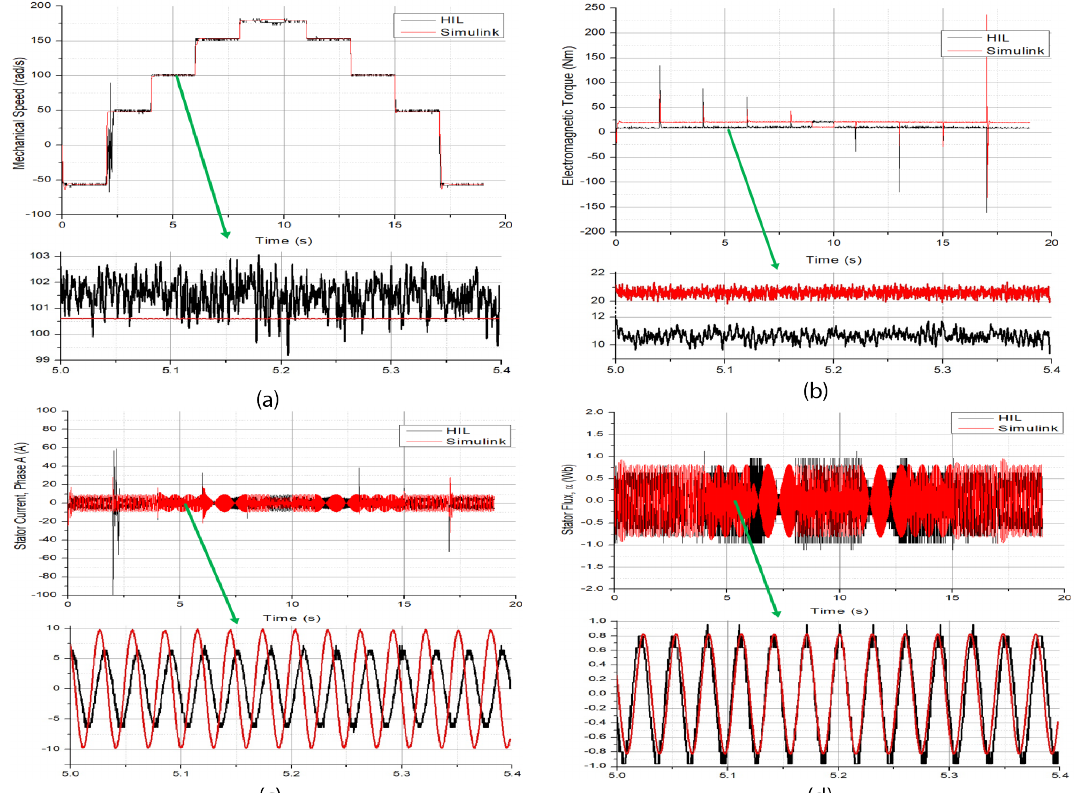
Figure 8. Numerical and practical results of the IFOC variable speed controller: ( a ) speed; ( b ) torque; ( c ) stator current; and ( d ) stator